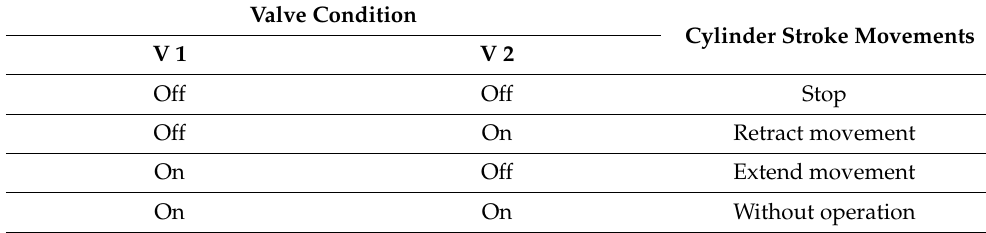
Table 1. The cylinder stroke’s movements based on the valve’s operations.